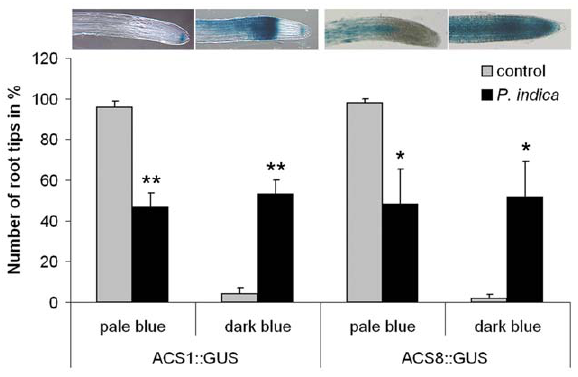
Figure 5. GUS accumulation in roots of ACS1 :: GUS and ACS8 :: GUS reporter plants colonized by P.indica . Arabidopsis lines ACS1 :: GUS and ACS8 :: GUS were harvested at 7 dai and, after GUS and WGA-AF 488 staining, analyzed cytologically. GUS staining was more pronounced in root tip regions of colonized roots as compared to mock-treated roots (upper images). At 7 dai, P. indica -colonized roots of both lines showed a significant increase of dark blue tips and a significant reduction in pale blue tips as compared to mock-treated roots. GUS staining did not colocalize with colonization sites of P. indica or extracellular fungal growth. The data base on at least two biological experiments. Asterisks indicate significant differences between control and P. indica -colonized roots according to Students t -test (* P , 0.05, **